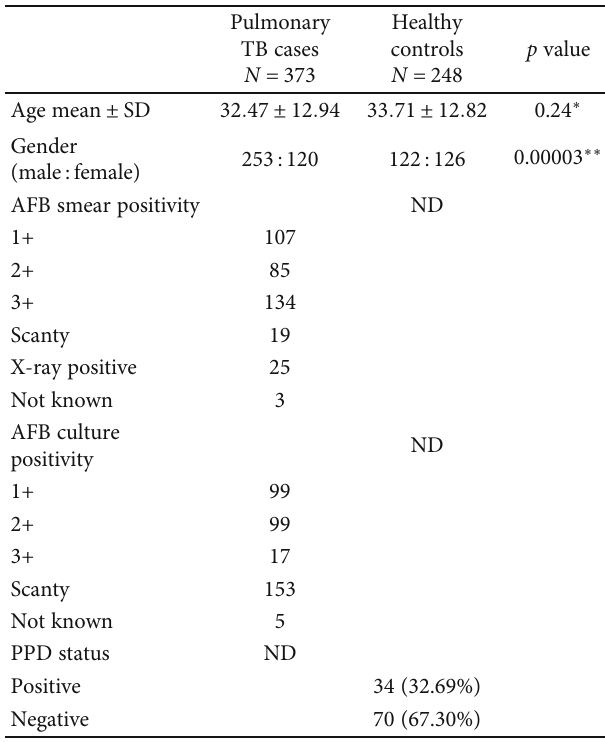
Table 1: Characteristics of pulmonary TB cases and healthy controls included in the